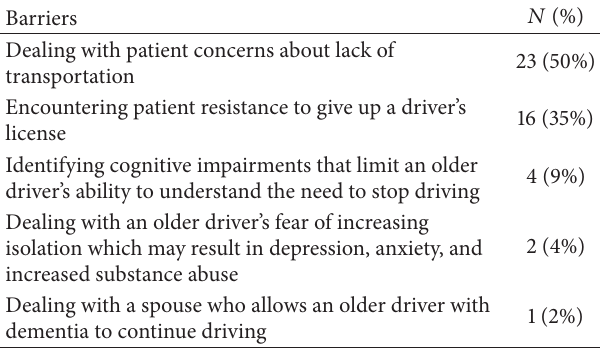
Table 4: Most frequently encountered barriers ( 𝑛 = 46 ). Barriers 𝑁